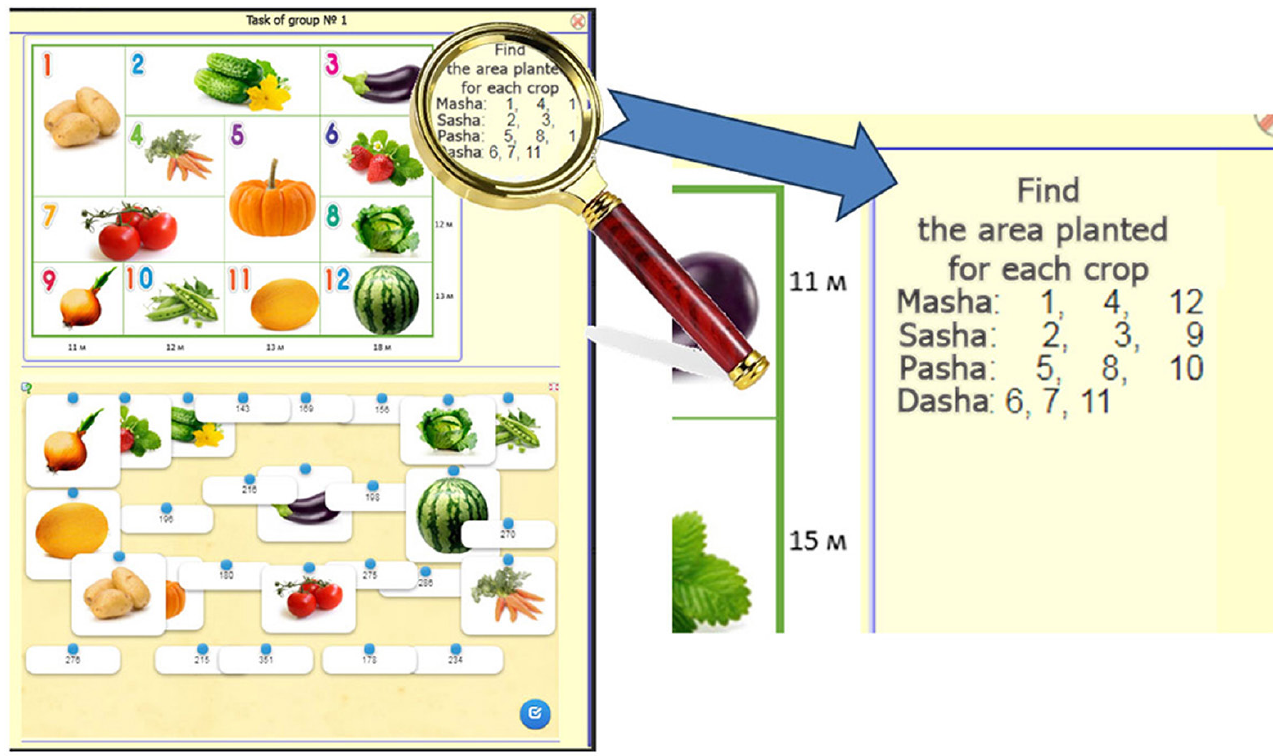
Fig. 9. Example of using the LearningApps.org service application as the ontograph node content (electronic textbook page